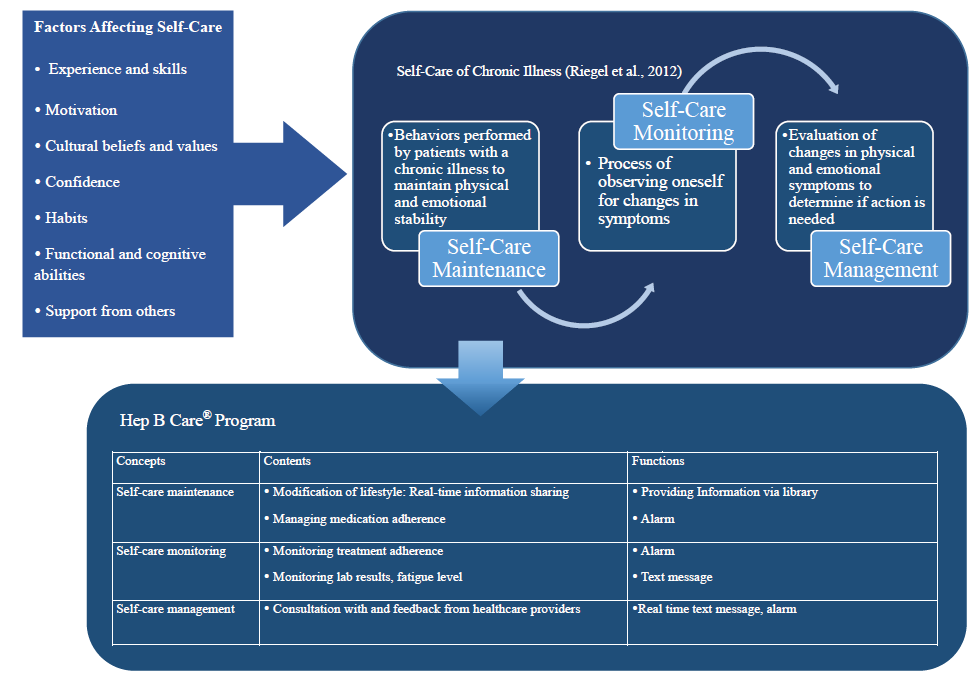
Figure 1. Theoretical framework used in this study.